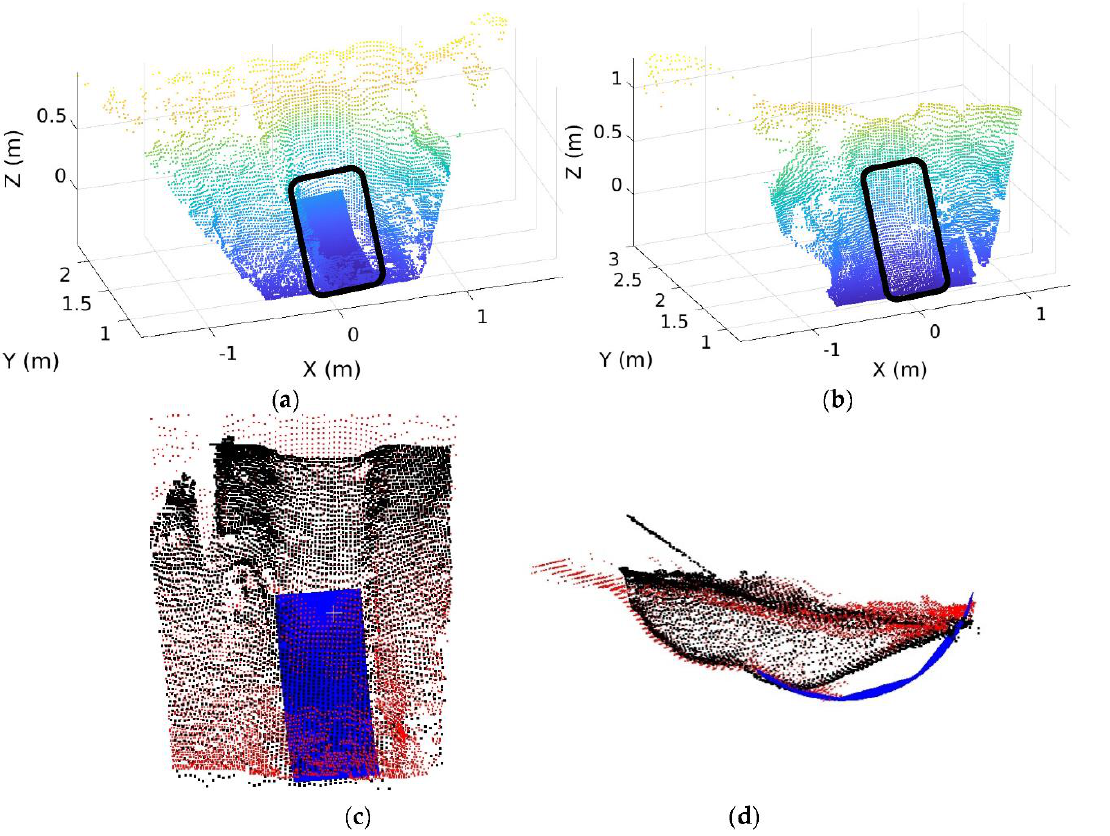
Figure 24. ( a ) Reconstructed map after excavation at the front side; ( b ) Ground map at the opposite side without the FOV blockage; ( c ) Overlap between Figure 24a,b in the top view; ( d ) Overlap between Figure 24a,b in the side view.